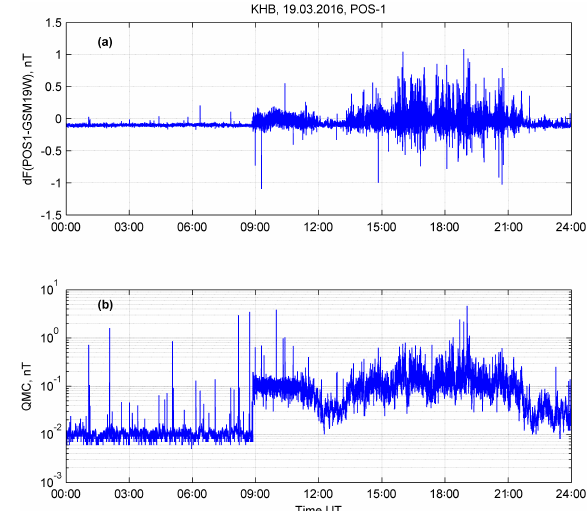
Figure 9. Noise caused by a snow plough clearing the path to the pavilions at the Khabarovsk observatory. Variations d H , d D and d Z were recorded by quartz magnetometer CAIS. Oscillations on the records are the result of the tractor work at a distance of about 30m from the magnetometer.